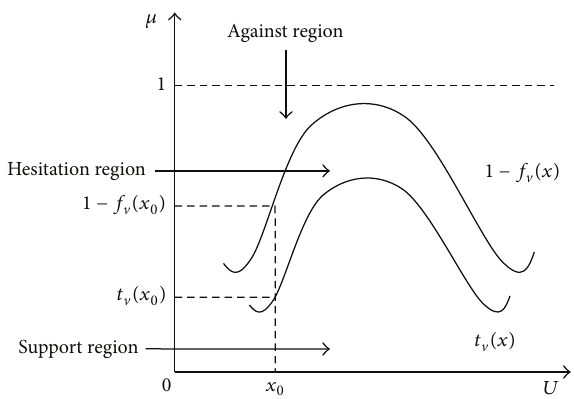
Figure 1: Vague membership